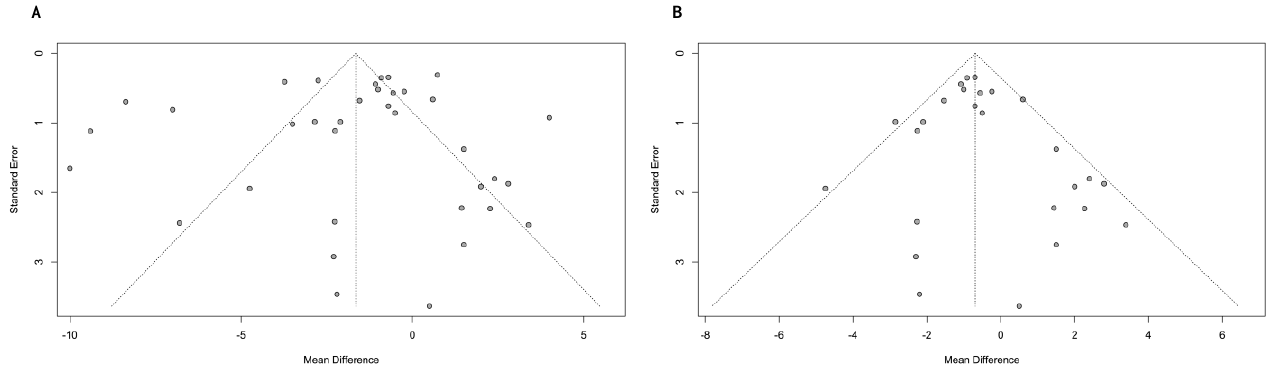
Figure 4. Funnel plots for publication bias. ( A ) Primary analysis with 36 studies and ( B ) sensitivity analysis with 26 studies.